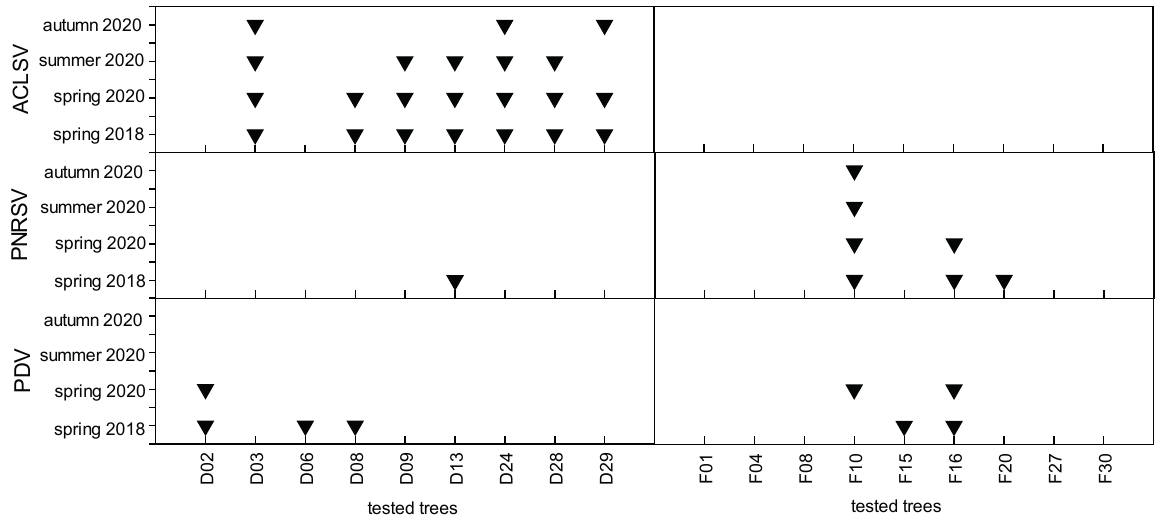
Figure 1. Seasonal fluctuations in detection of virus positive trees using RT-PCR during autumn 2020, summer 2020, spring 2020 and spring 2018 (y-axes for apple chlorotic leaf spot virus (ACLSV), Prunus necrotic ringspot virus (PNRSV) and prune dwarf virus (PDV). Each triangle indicates positively tested trees ( n = 9) for orchards D (left) and F